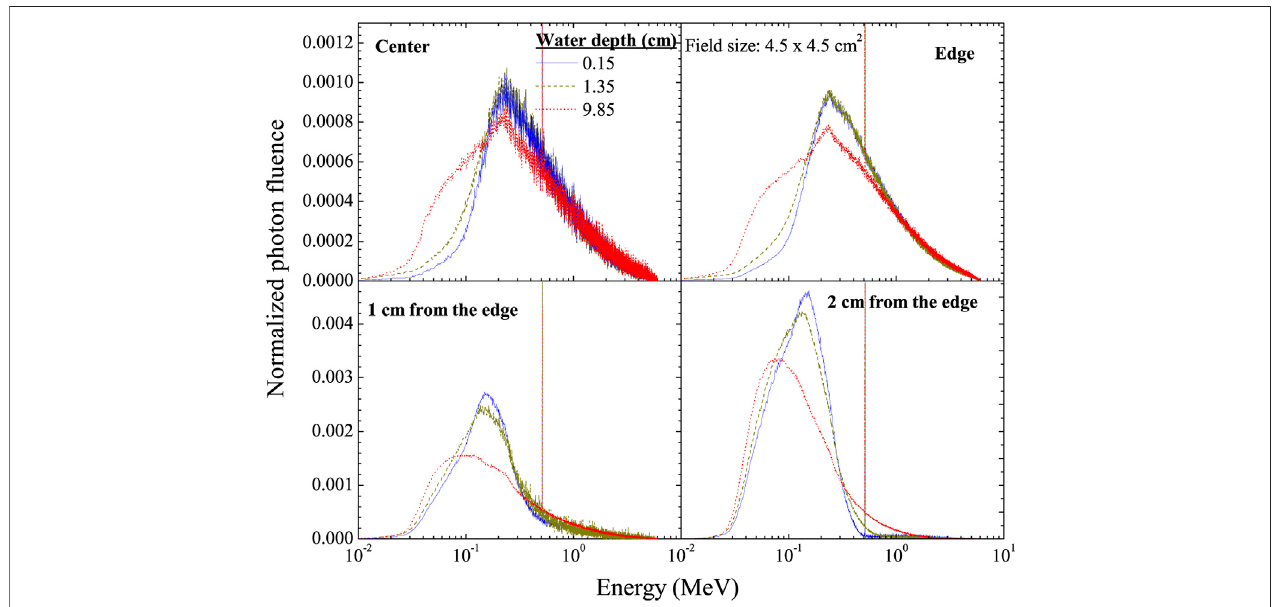
FIGURE 2 | Normalized photon fl uence as a function of photon energy at several OADs for the 4.5 × 4.5 cm 2 fi eld size.